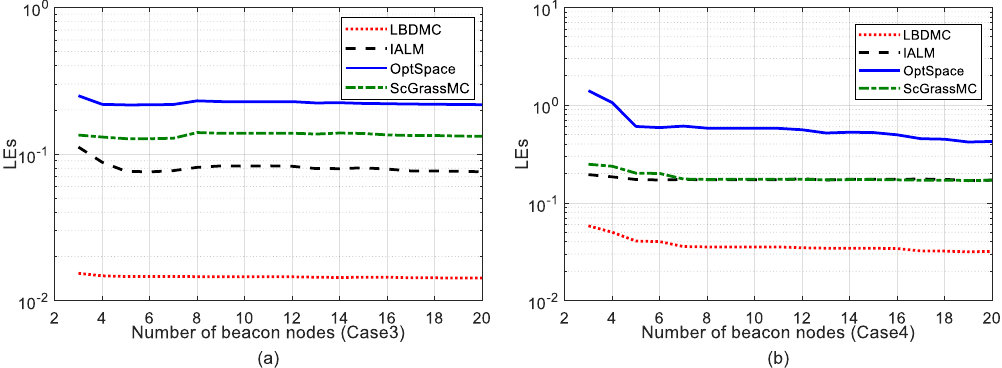
Figure 4. Mean localization error versus different number of beacons. The number of beacons varies successively from 3 to 20. The sampling rate is fixed at 50%: ( a ) Mean localization error under Case 3; ( b ) Mean localization error under Case 4.